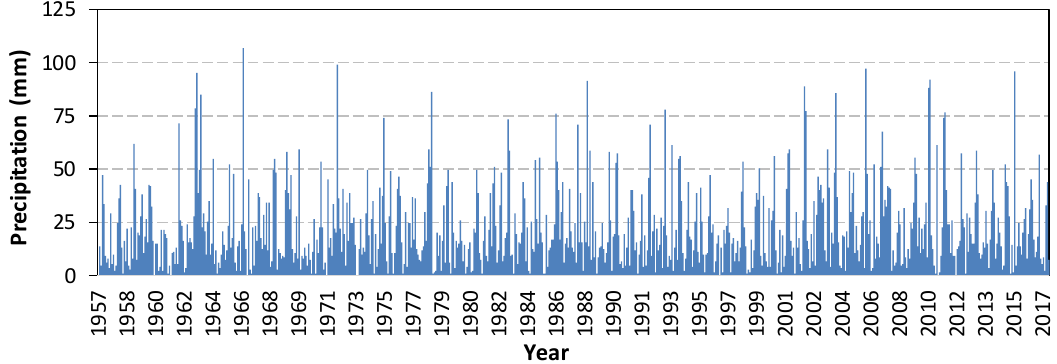
Figure 6. Monthly total precipitation (mm) data for Igdir meteorology station.